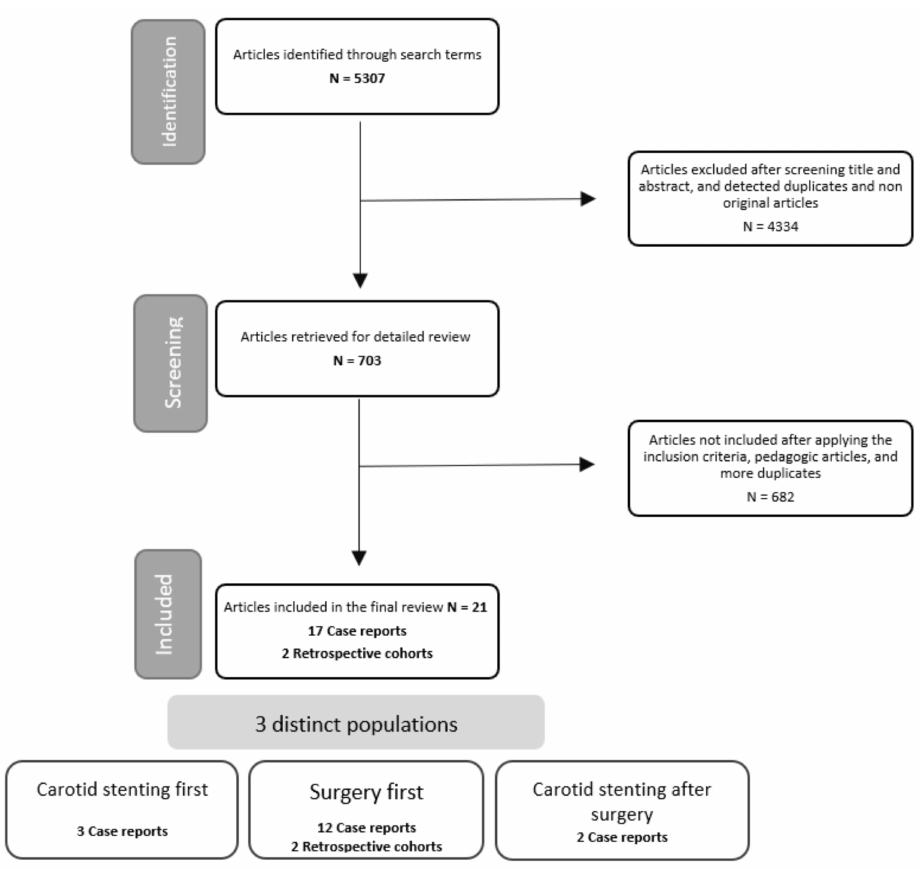
Figure 1. Flowchart of included